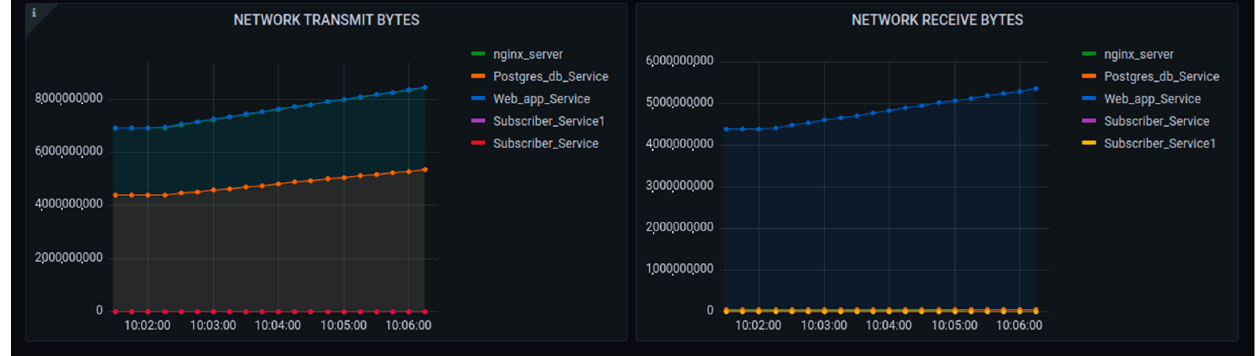
Figure 20. Performance of the platform after scaling up with requests to 1000 network data transmissions.